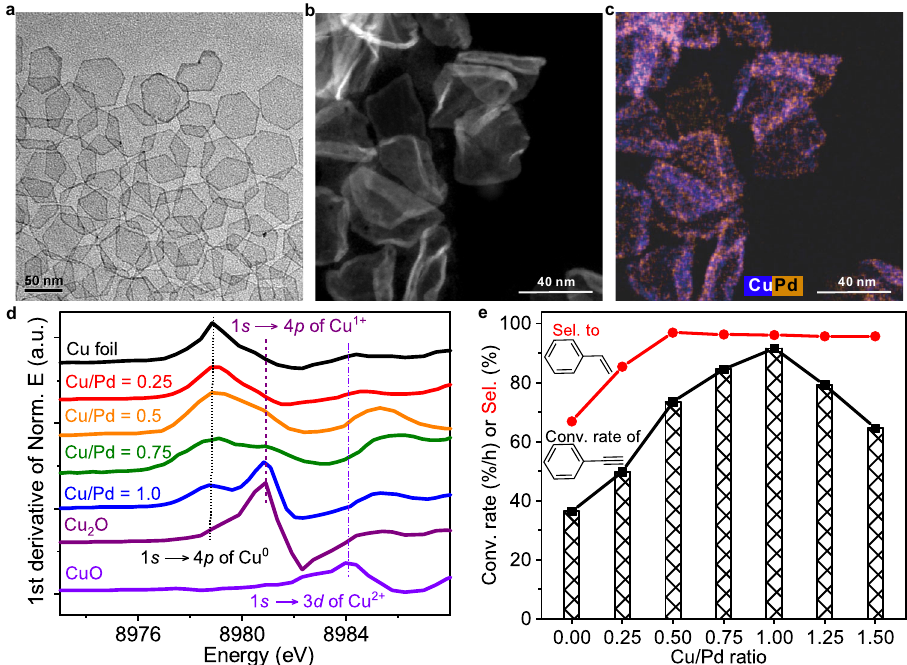
Fig. 1 Structure characterizations and catalytic performance of PdCu@Cu 2 O. a Representative TEM images of Pd NSs. b High-resolution high-angle annular dark- fi eld (HAADF) STEM image of PdCu@Cu 2 O (Cu/Pd = 1). c STEM-EDS elemental mapping of PdCu@Cu 2 O (Cu/Pd = 1). d The fi rst derivatives of Cu K-edge XANES of PdCu@Cu 2 O with different Cu/Pd ratio and references. e Catalytic performance of semi-hydrogenation of PhC ≡ CH on PdCu@Cu 2 O with different Cu/Pd ratios. Reaction conditions: 10 mL ethanol; 2 μ mol Pd; 4 mmol PhC ≡ CH (1:2,000); T = 303 K; H 2 pressure = 0.1 MPa (PhC ≡ CH was introduced before H 2